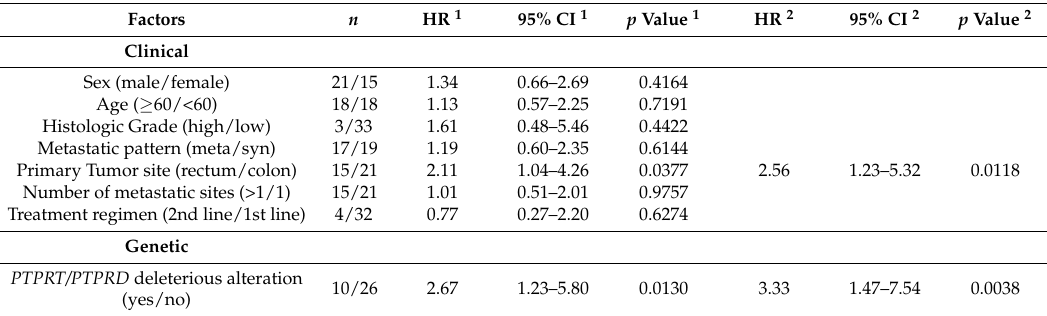
Table 3. Uni- and multivariate analysis of progression-free